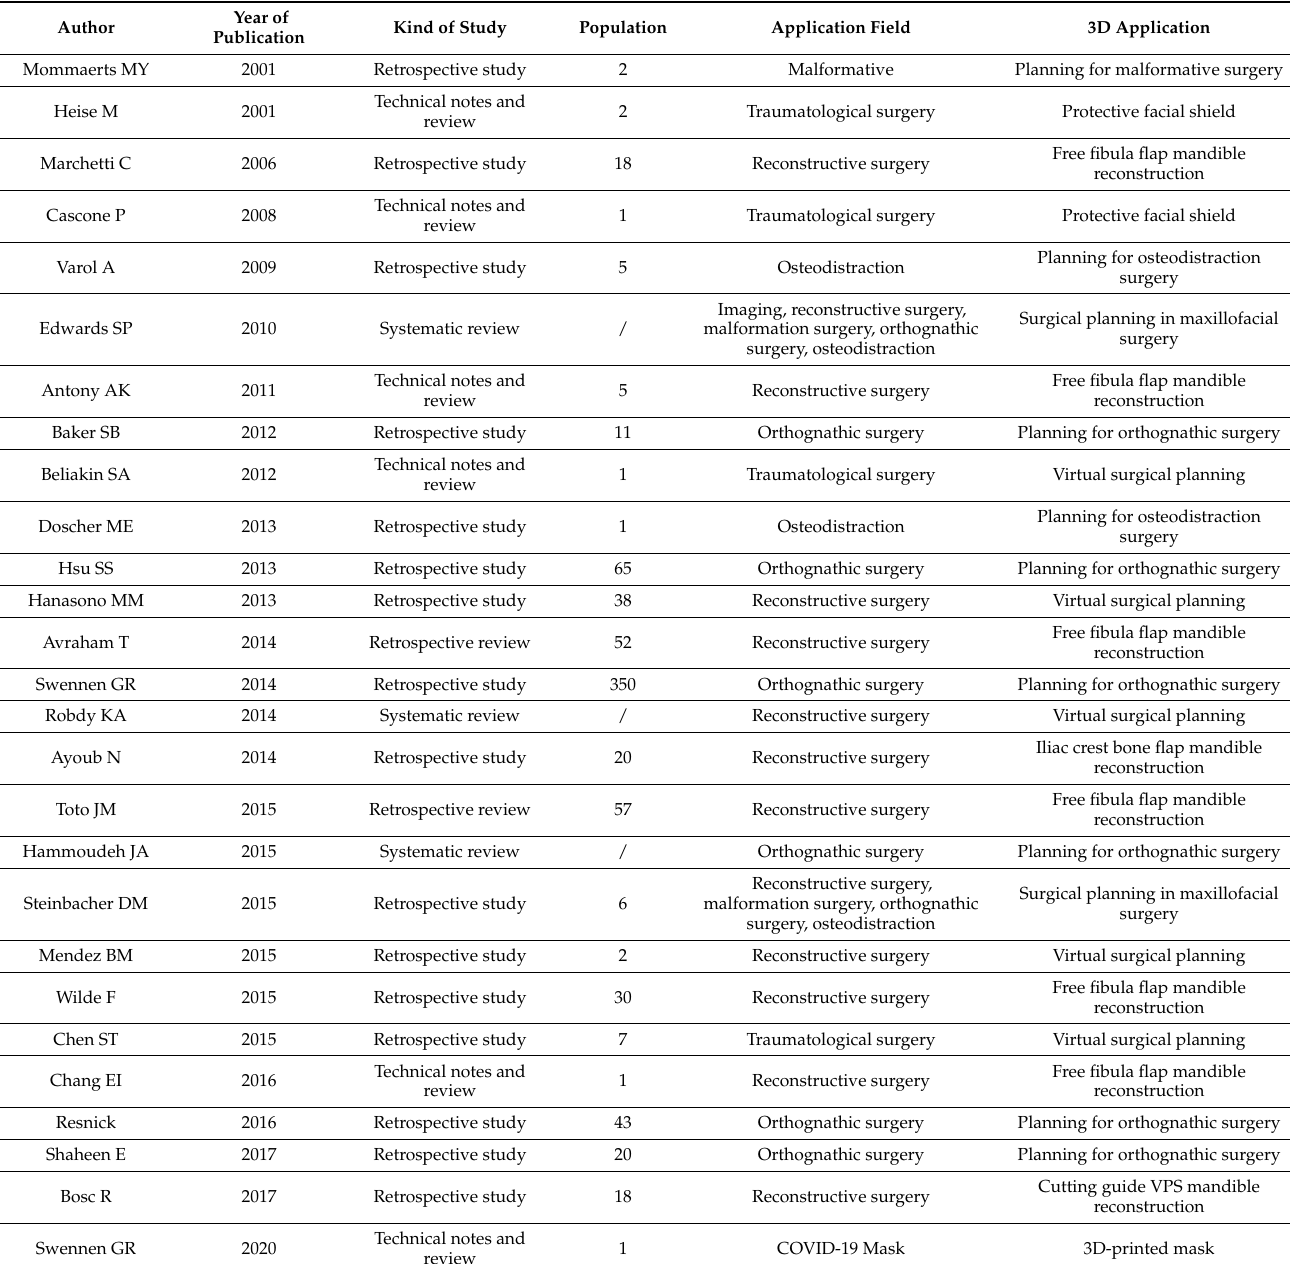
Table 2. Review of